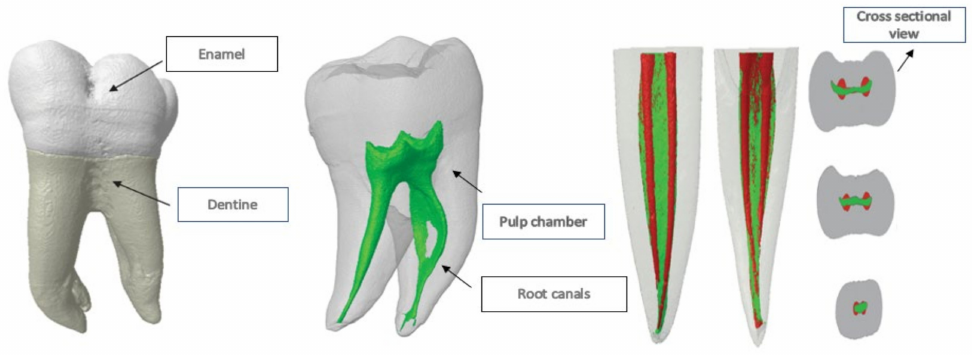
Figure 1. Micro-CT in